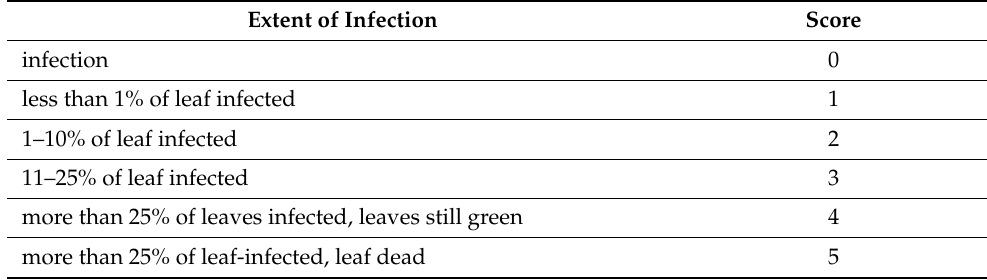
Table 2. Score for disease severity rating given to the plant